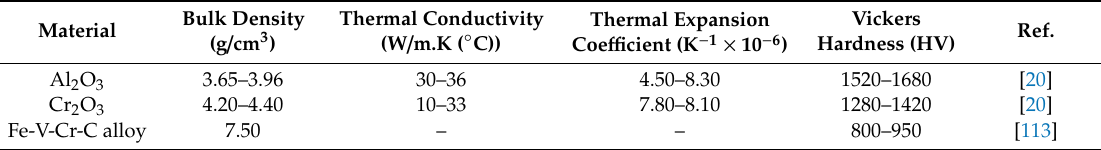
Table 5. Summary of promising coating materials for brake disc